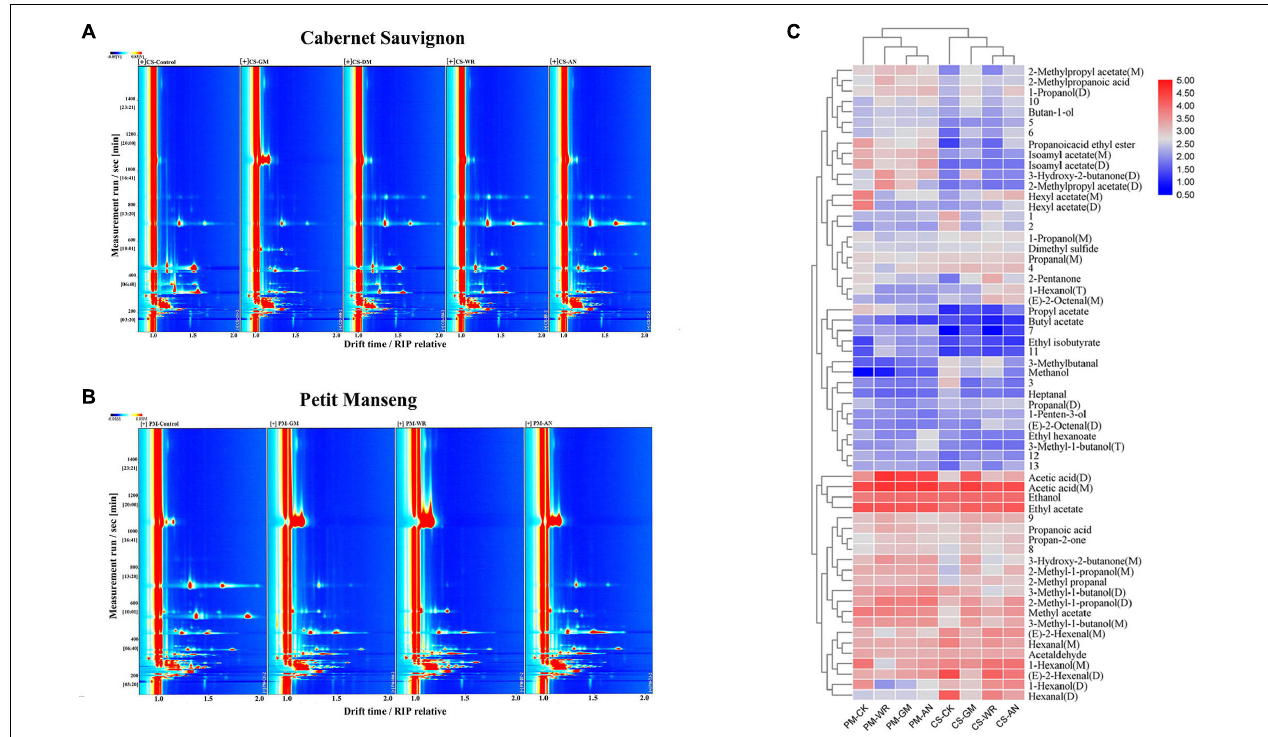
FIGURE 3 | (A, B) Comparison of GC-IMS spectra and (C) Heatmap with clustering analysis of VOCs. The numbers in panel (A, B) represent VOCs with large differences (the compound names are shown in Supplementary Table 1 ). (C) shows the changes in VOCs induced by pathogenic fungal infestation with the control group in Cabernet Sauvignon and Petit Manseng wine